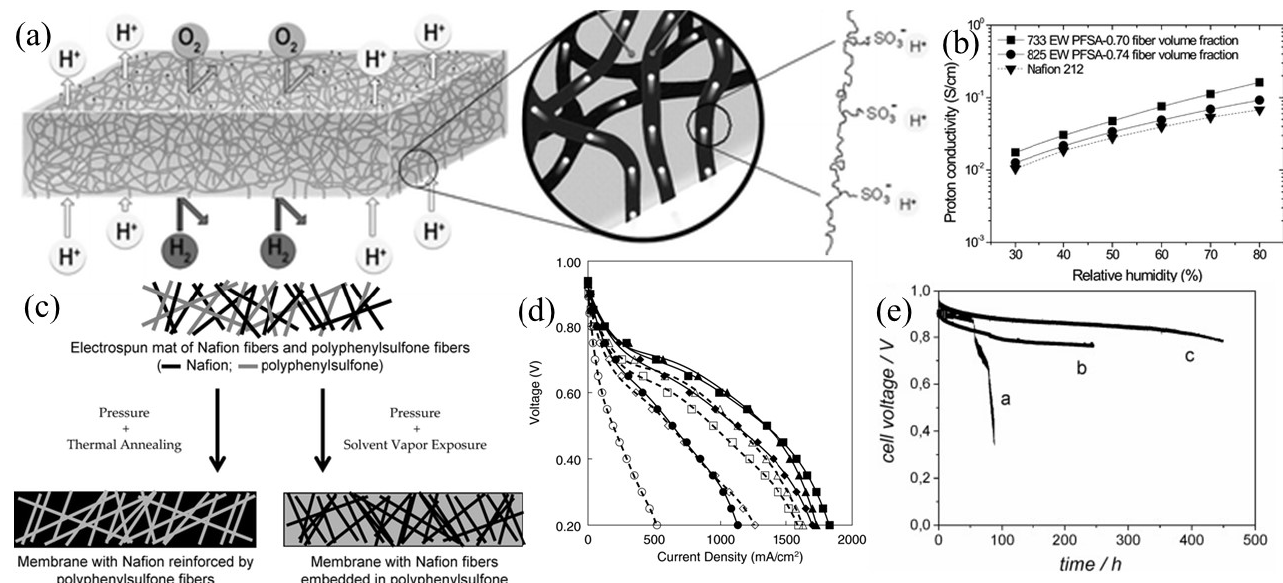
Figure 3. ( a ) Schematic diagram of a nanofiber composite PEM. Reproduced with permission from Ref. [56]. ( b ) Variation of in-plane proton conductivity with RH at 80 °C for two nanofiber composite membranes and for Nafion 212. Reproduced with permission from Ref. [57]. ( c ) Two kinds of nanofiber composite Nafion/PPSU membrane structures from the same electrospun dual-fiber mat. Reproduced with permission from Ref. [79]. ( d ) Polarization curves at 80 °C for a 3M Co. PFSA ionomer MEA (with a 3M 660 EW PFSA/PPSU nanofiber composite membrane) and a Nafion ionomer MEA (with a Nafion 211 membrane). ( ▲ ) 3M MEA at 93% RH; ( ■ ) 3M MEA at 75% RH; ( ♦ ) 3M MEA, at 50% RH; (•) 3M MEA at 25% RH; (Δ) Nafion MEA at 93% RH; (□) Nafion MEA at 75% RH; (◊) Nafion MEA at 50% RH; ( ○ ) Nafion MEA at 25% RH. Reproduced with permission from Ref. [59]. ( e ) The results of an OCV hold membrane durability test, where the change in OCV at 90 °C is plotted as a function of time for MEAs incorporating: ( a ) a non-reinforced Aquivion membrane, ( b ) a membrane composed of PSU fiber-reinforced Aquivion, and ( c ) a membrane composed of Aquivion reinforced with 30 mol% PSUT nanofibers. Reproduced with permission from Ref. [60].